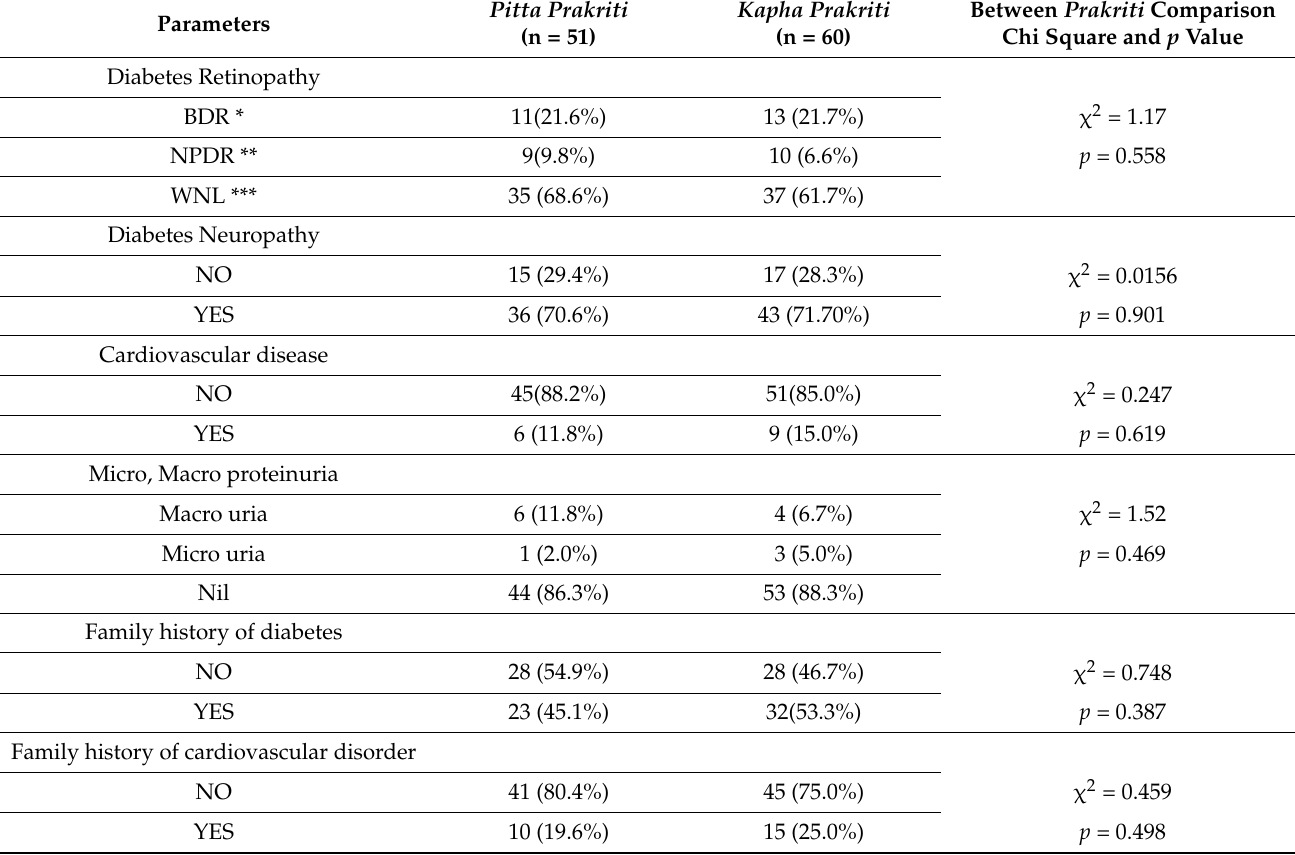
Table 2. Showing secondary complications and family history of the person with diabetes as per Prakriti. Pitta Prakriti Kapha Prakriti Between Prakriti Comparison Parameters (n = 51) (n = 60) Chi Square and p